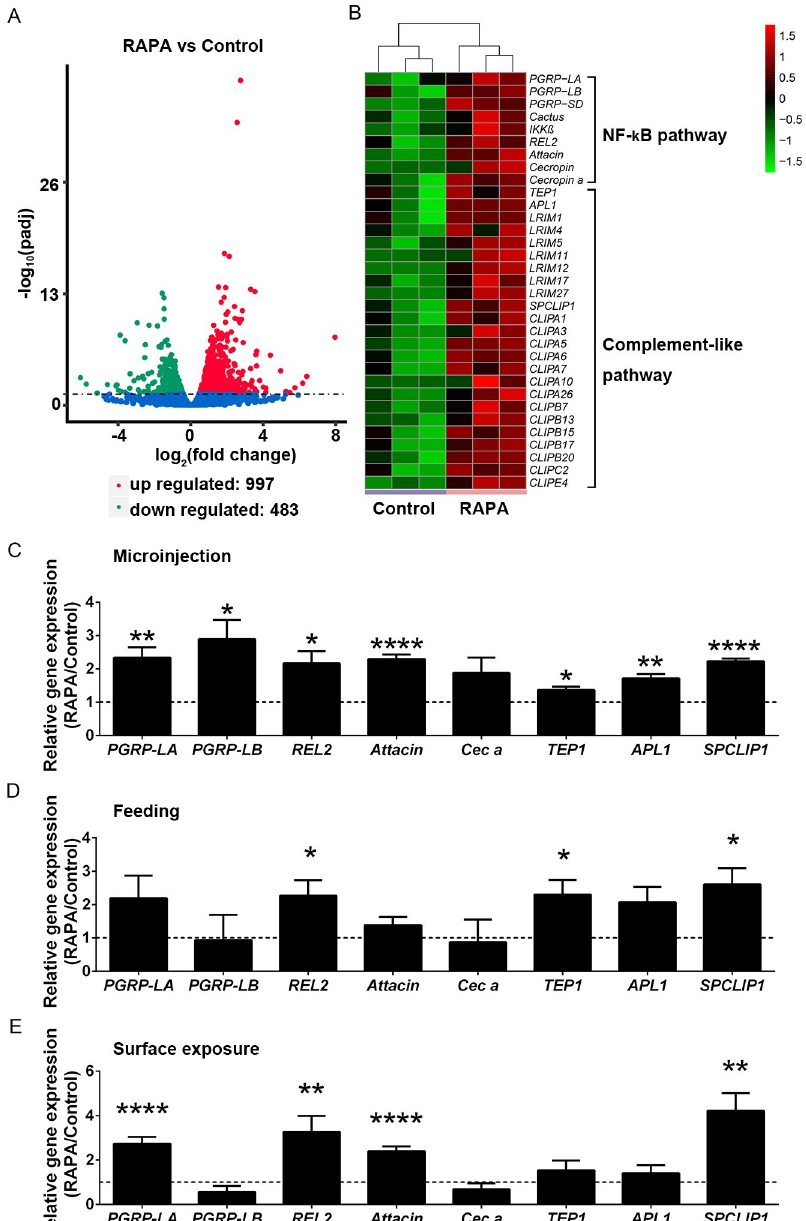
Fig 4. Transcriptome analysis of rapamycin-treated An . stephensi in response to Plasmodium infection. (A) The volcano plot of differentially expressed genes in rapamycin-treated mosquitoes versus controls 24 hpi. Red circles represent 997 significantly up-regulated genes, and green circles represent 483 significantly down-regulated genes (P adj < 0.05). (B) Heat map of immune genes induced by rapamycin. The entire list of differentially expressed genes is shown in S1 Table. (C - E) Quantification of upregulated genes by microinjection, feeding, and surface exposure to rapamycin. The expression levels of targeted genes were normalized to S7 . Relative gene expression in rapamycin- treated mosquitoes was normalized to that of controls. Error bars indicate standard errors (n = 8). Results from one of two independent experiments are shown. Significance was determined by Student’s t -test; � P < 0.05, �� P < 0.01, ���� P <